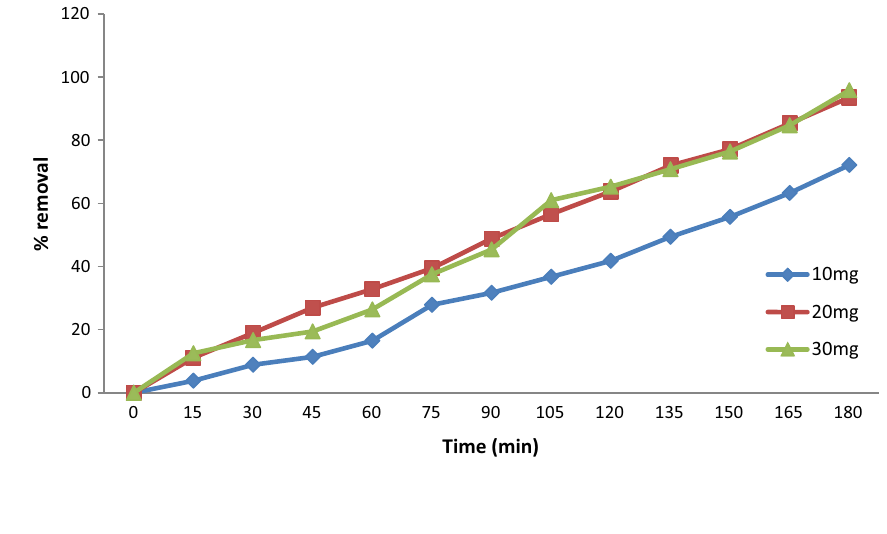
Fig. 9 Adsorption isotherm for chromium removal. a Langmuir isotherm. b Freundlich iso- therm. c Tempkin